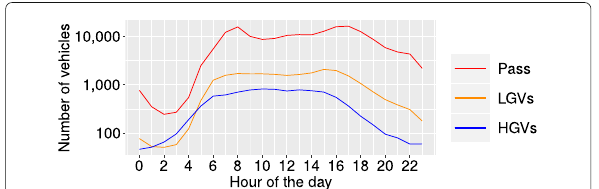
Fig. 16 Average number of vehicles in the region per hour